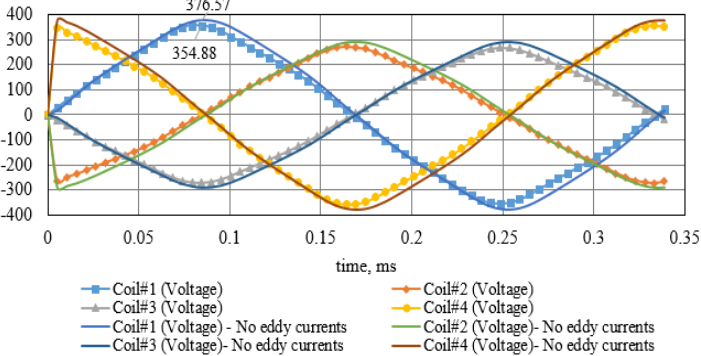
Figure 22. TFM with electrically conducting and non-conducting titanium rotor hubs where electri- cally conductive titanium rotor hub causes a drop in back EMFs at rated speed.